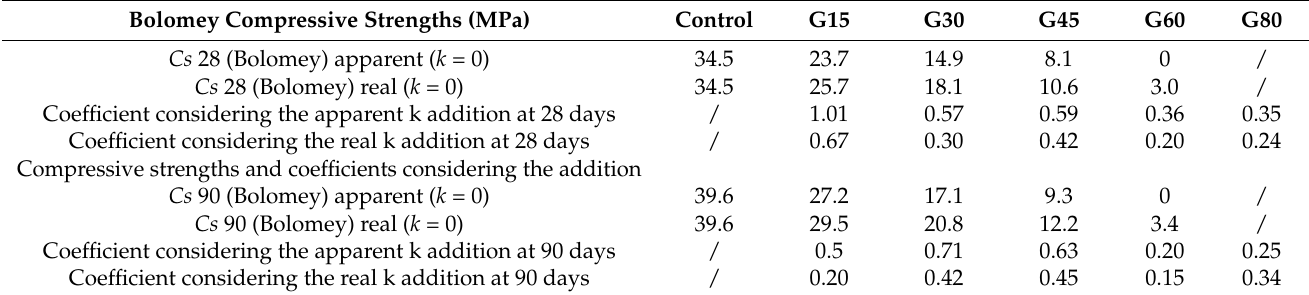
Table 6. Results of Bolomey’s ‘apparent’ and ‘real’ compressive